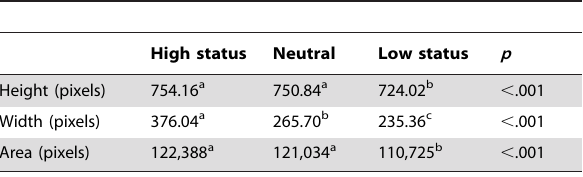
Table 4. Perceived size as a function of status cues in Experiment 4.